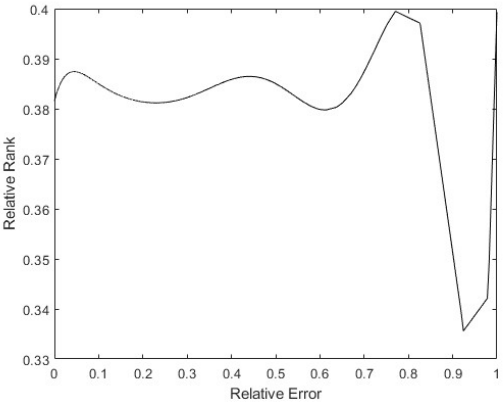
Figure 23. Polynomial regression of relative rank to relative error on X 2 .